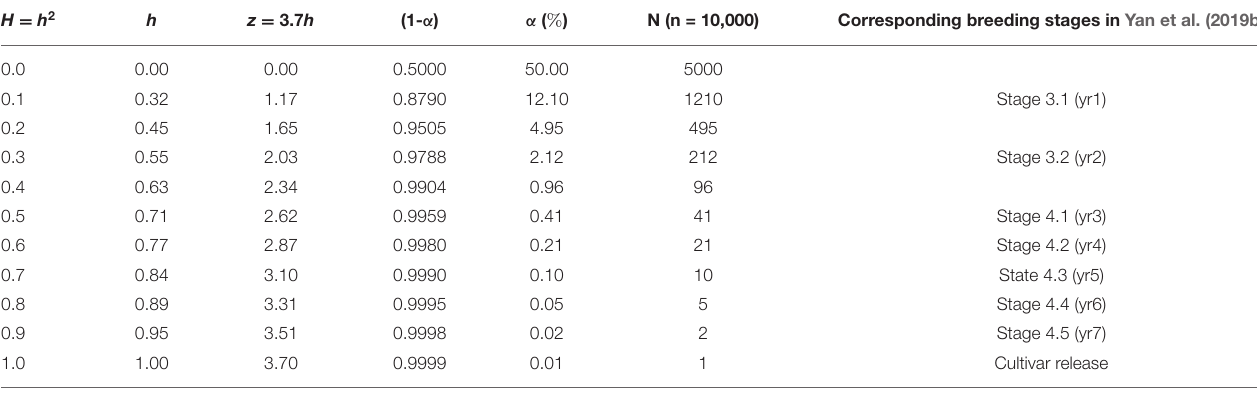
TABLE 1 | The realized selection intensity ( z heritability ( H or h 2 ) assuming a population of n